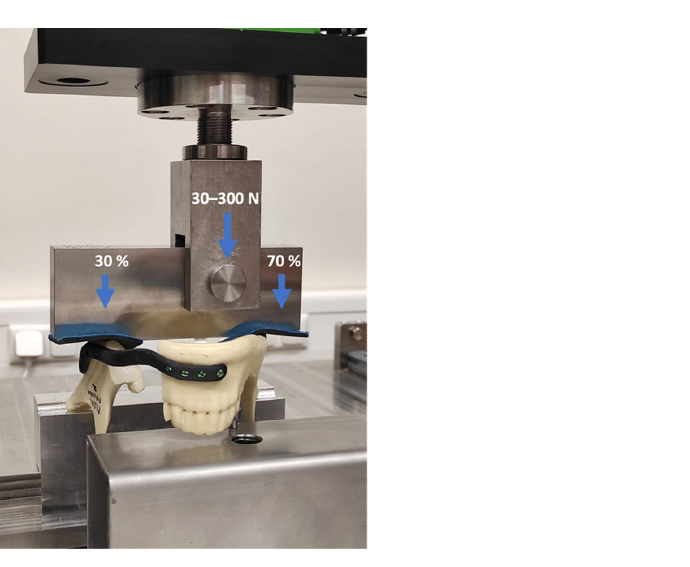
Figure 3 . Display of servo ‐ hydraulic mechanical testing with a MTS Bionix (Eden Prairie, MN, USA) testing machine. Cyclical loading of bite forces between 30 and 300 N with distribution of 30% of maximum force on the resected and 70% on the unresected side of the mandible.